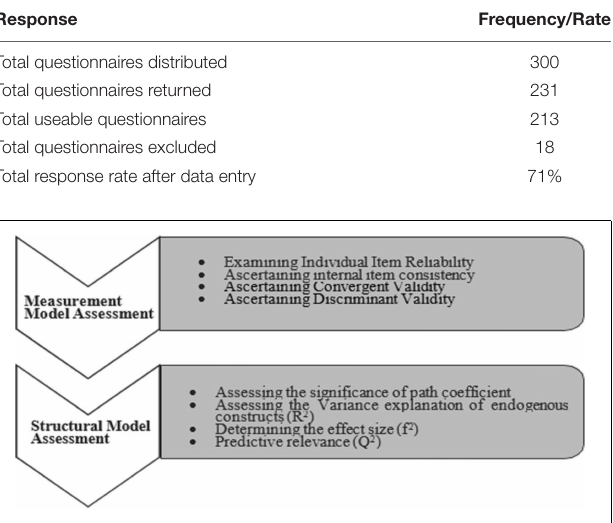
TABLE 1 | Response from respondents.